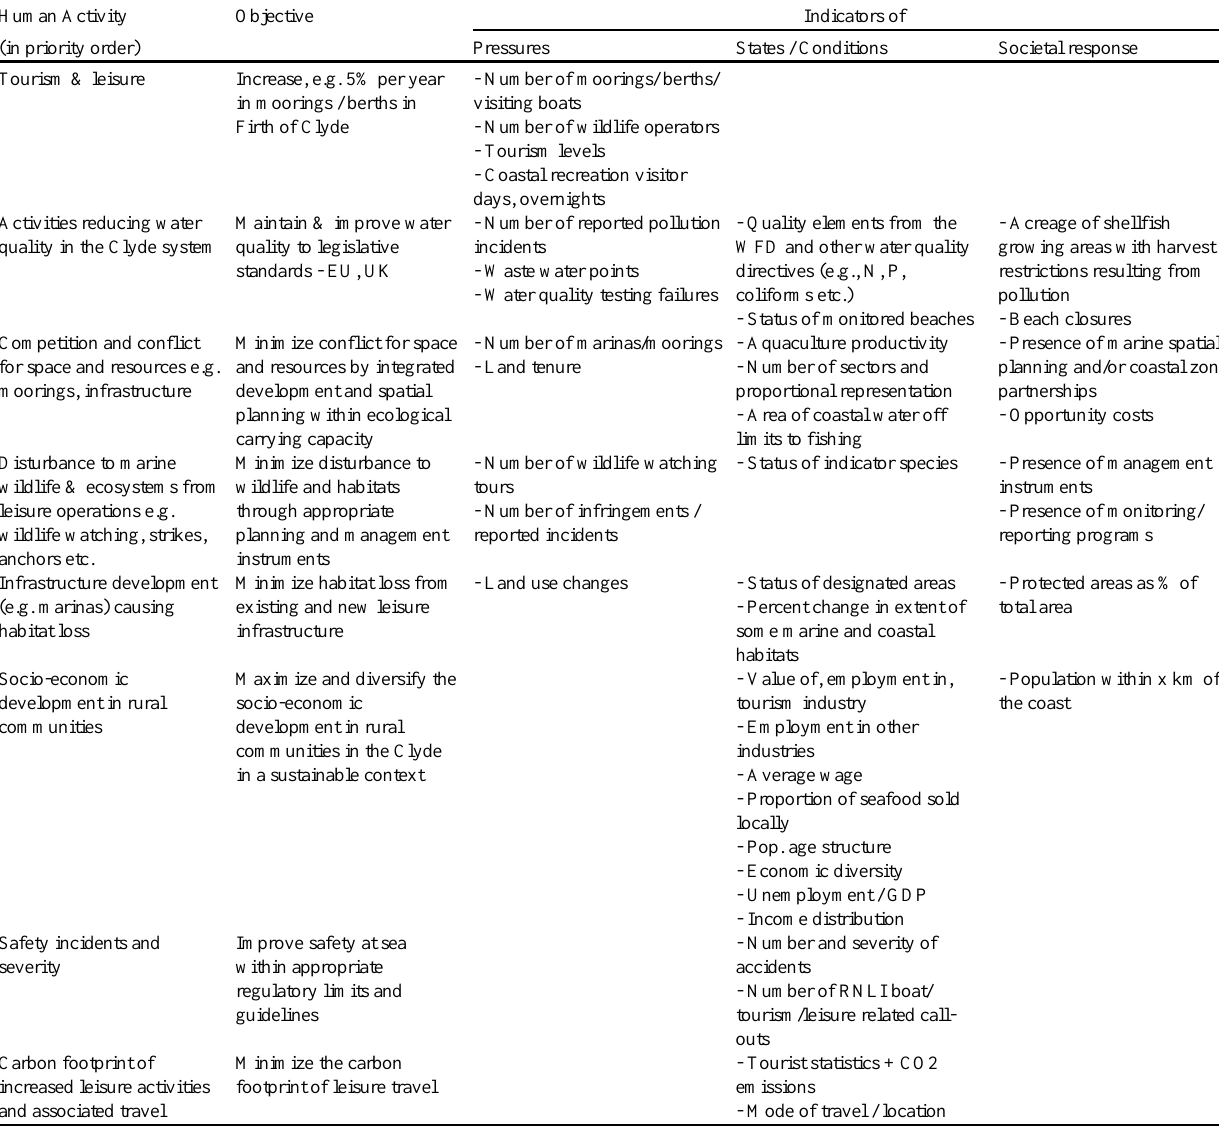
Table 2 . Potential Policy